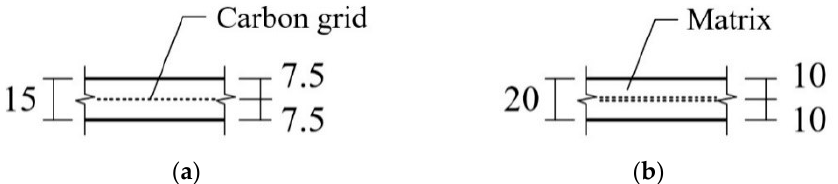
Figure 6. Configuration of the textile reinforced concrete (TRC) system. ( a ) 15 mm thick (one-ply textile); ( b ) 20 mm thick (two-ply textile) (units, mm).